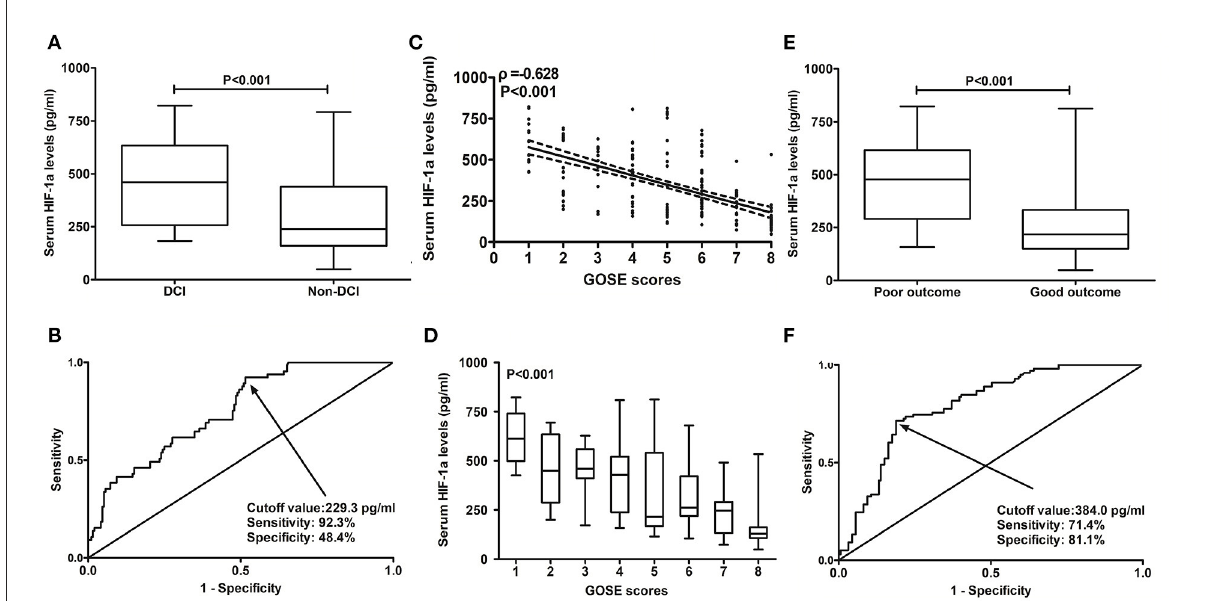
FIGURE4 Predictive ability of serum hypoxia-inducible factor 1alpha levels for patients at risk of delayed cerebral ischemia and 6-month poor outcome after aneurysmal subarachnoid hemorrhage. (A) Serum hypoxia-inducible factor 1alpha levels between patients with delayed cerebral ischemia and those not presenting with delayed cerebral ischemia. Serum hypoxia-inducible factor 1 alpha levels were profoundly higher in patients with delayed cerebral ischemia than in other remainders ( P < 0.001). (B) Discriminatory power of serum hypoxia-inducible factor 1alpha levels for risk of delayed cerebral ischemia. Serum hypoxia-inducible factor 1alpha levels substantially distinguished the development of delayed cerebral ischemia ( P < 0.001). Using the Youden method, an optimal cutoff value was chosen, which produced the corresponding sensitivity and specificity values. (C) Relation of serum hypoxia-inducible factor 1alpha levels to extended Glasgow outcome scale scores. Serum hypoxia-inducible factor 1alpha levels were substantially correlated with extended Glasgow outcome scale scores ( P < 0.001). (D) Serum hypoxia-inducible factor 1alpha levels among patients with different extended Glasgow outcome scale scores. Serum hypoxia-inducible factor 1alpha levels were substantially highest in patients with extended Glasgow outcome scale score of 1, followed by extended Glasgow outcome scale scores of 2–7, and were markedly lowest in those with extended Glasgow outcome scale score of 8 ( P < 0.001). (E) Serum hypoxia-inducible factor 1alpha levels between patients with poor outcomes and those with good outcomes. Serum hypoxia-inducible factor 1 alpha levels were profoundly higher in patients with poor outcomes than in those with good outcomes ( P < 0.001). (F) Distinguishable value of serum hypoxia-inducible factor 1alpha levels for poor outcomes. Serum hypoxia-inducible factor 1alpha levels pronouncedly discriminated poor outcomes ( P < 0.001). Using the Youden method, an optimal cutoff value was selected, which yielded the corresponding sensitivity and specificity values. HIF-1 α , hypoxia-inducible factor 1alpha; GOSE, extended Glasgow outcome scale; DCI, delayed cerebral